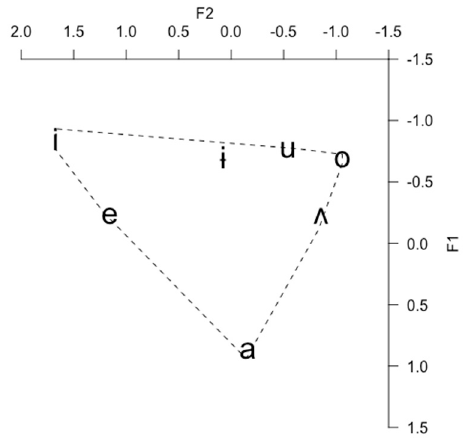
Figure 2. Korean vowel space of young generation Koreans (adapted from Kang and Kong (2016)).